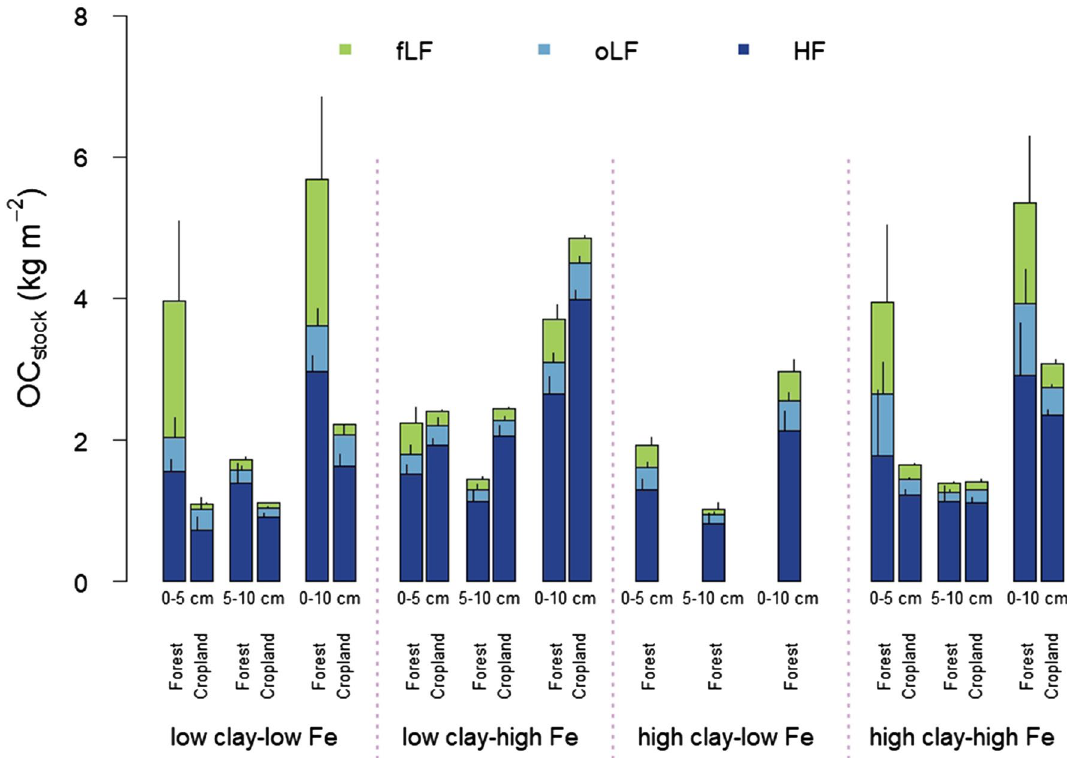
Figure 3. Bulk OC stocks related to soil density fractions (fLF and oLF = free and occluded light fraction; HF = heavy fraction) in mineralogical combinations under forest and cropland separated by soil depth. Sample numbers for the combinations are as follows: ‛ low clay ‒ low Fe’ under forest ( n = 4), ‛ low clay ‒ high Fe’ under forest ( n = 4), ‛ high clay ‒ low Fe’ under forest ( n = 3), ‛ high clay ‒ high Fe’ under forest ( n = 7); all cropland combinations ( n =